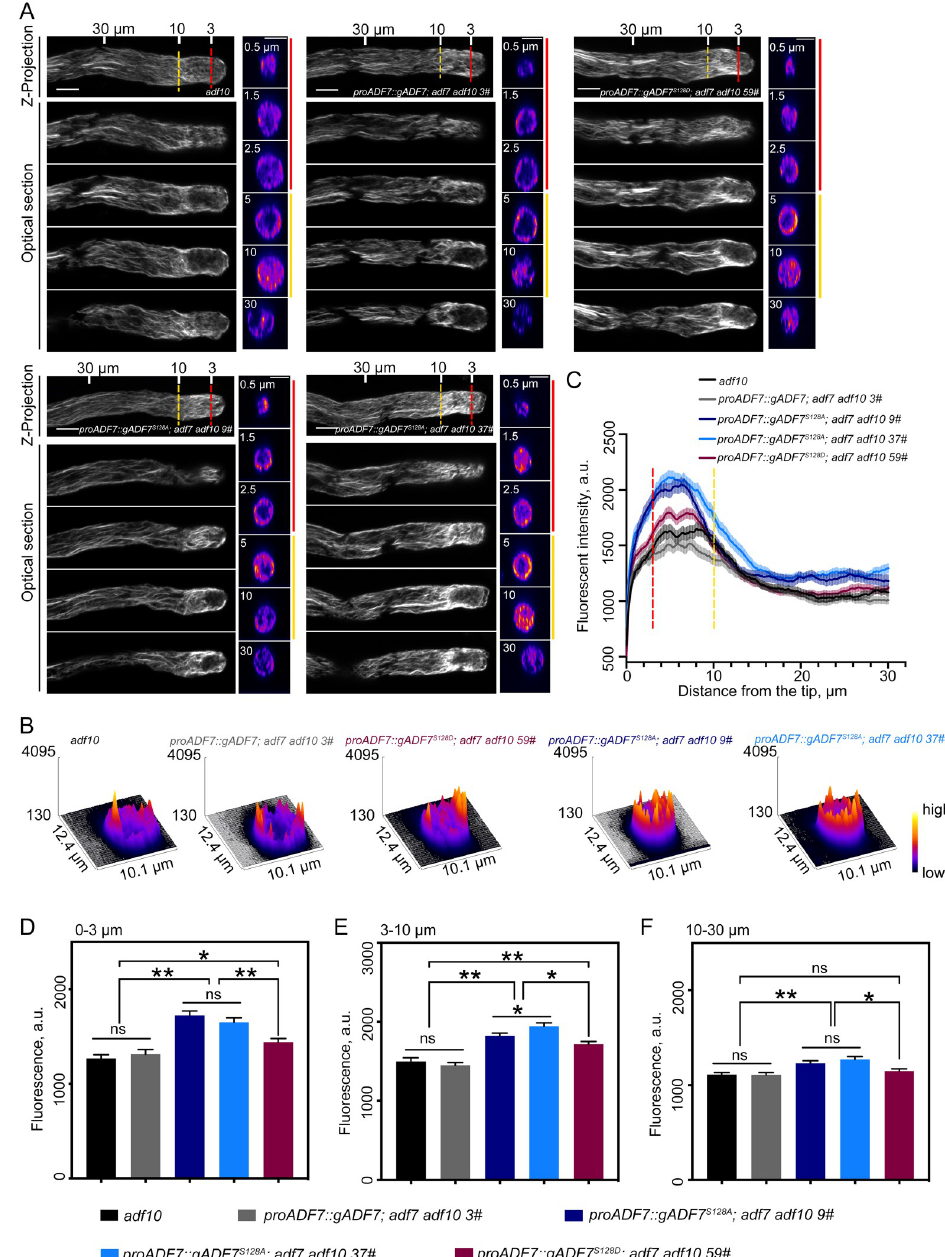
Fig 5. ADF7 S128A has less activity than ADF7 in restoring the actin turnover defects caused by loss of ADF7 in pollen tubes. ( A ) Images of actin filaments in pollen tubes. Pollen tubes derived from adf10 , proADF7 :: gADF7; adf7 adf10 , proADF7 :: gADF7 S128A ; adf7 adf10 and proADF7 :: gADF7 S128D ; adf7 adf10 were subjected to actin staining with Alexa-488 phalloidin. The projection images and the associated optical sections are presented. Several transverse sections derived from the same pollen tube are shown in the right panels; the distance of these sections from the pollen tube tip is indicated in the images. The dashed red lines indicate the base of the apical region (3 μ m from tube tip), and the dashed yellow lines indicate the base of the subapical region (10 μ m from tube tip). Bars = 5 μ m. ( B ) The 3D distribution of fluorescence intensity of actin filaments within the apical region (0–3 μ m from tube tip), which was generated by ImageJ software with a 3D interactive “Surface Plot” function. Warm and cold colors indicate higher and lower fluorescence, respectively. Numerical data underlying this panel are available in S5 Data. ( C ) Quantification of the fluorescence intensity of actin filaments stained with Alexa-488 phalloidin in pollen tubes. The fluorescence intensity (mean ± SEM) was plotted from the tip to the base along the growth axis of pollen tubes. The dashed red lines indicate the base of the apical region (3 μ m from tube tip), and the dashed yellow lines indicate the base of